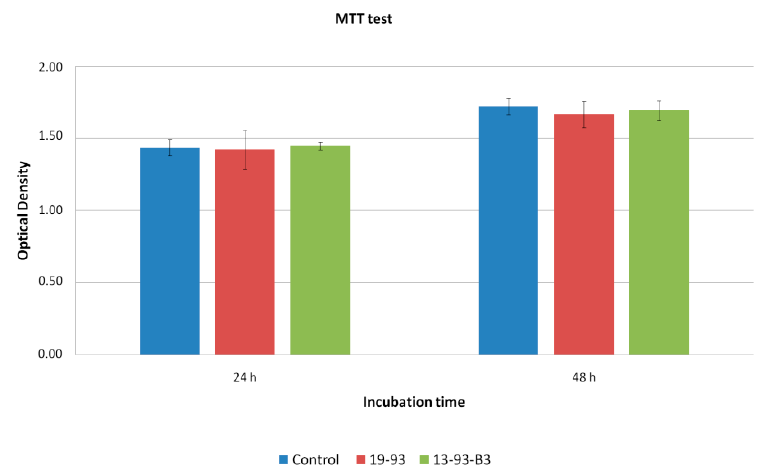
Figure 5. MTT results of 13-93 and 13-93-B3 BG coated Ti after 24 and 48 h of in vitro ADMSC culture, reported as optical density measured at 600 nm, expressed as mean values ± standard deviation of 3 independent experiments. Statistical analysis was performed through ANOVA, followed by post hoc Tukey test.